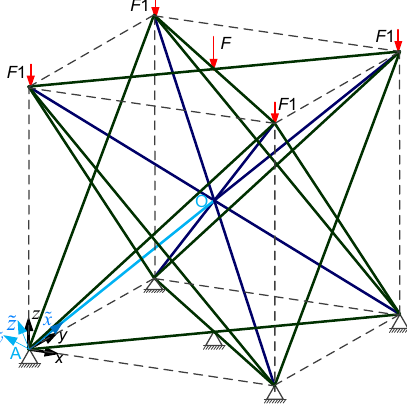
Figure 2. Force analysis diagram of the ground structure under applied loads.